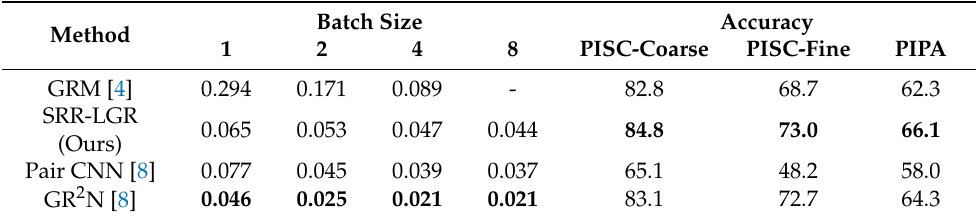
Table 5. Comparisons of running time (seconds/image) under different batch sizes for SRR on the PIPA dataset with the